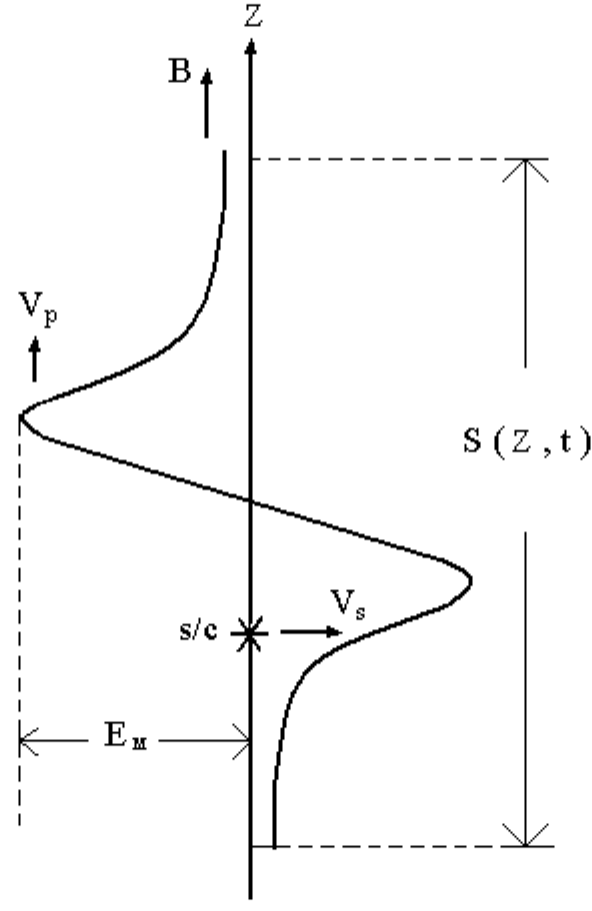
Fig. 3. A carton depicts how the bipolar EFS structure moving par- allel to the local magnetic field could appear in the spacecraft